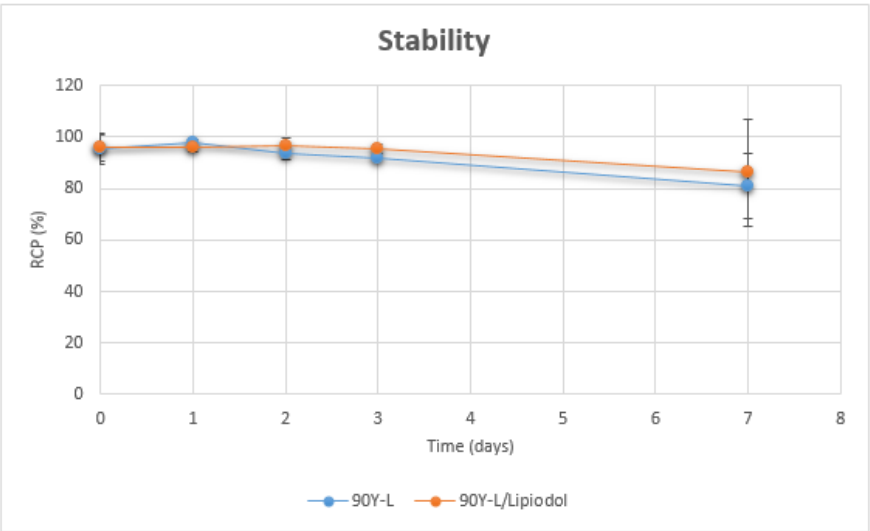
Figure 5. Stability of 90 Y-Hinokitiol and 90 Y-Hinokitiol/Lipiodol. In the presence of excess iron citrate, no transchelation between yttrium and iron was observed. RCP of 90 Y-Hinokitiol remained over 90% for 6 days (Figure 6).